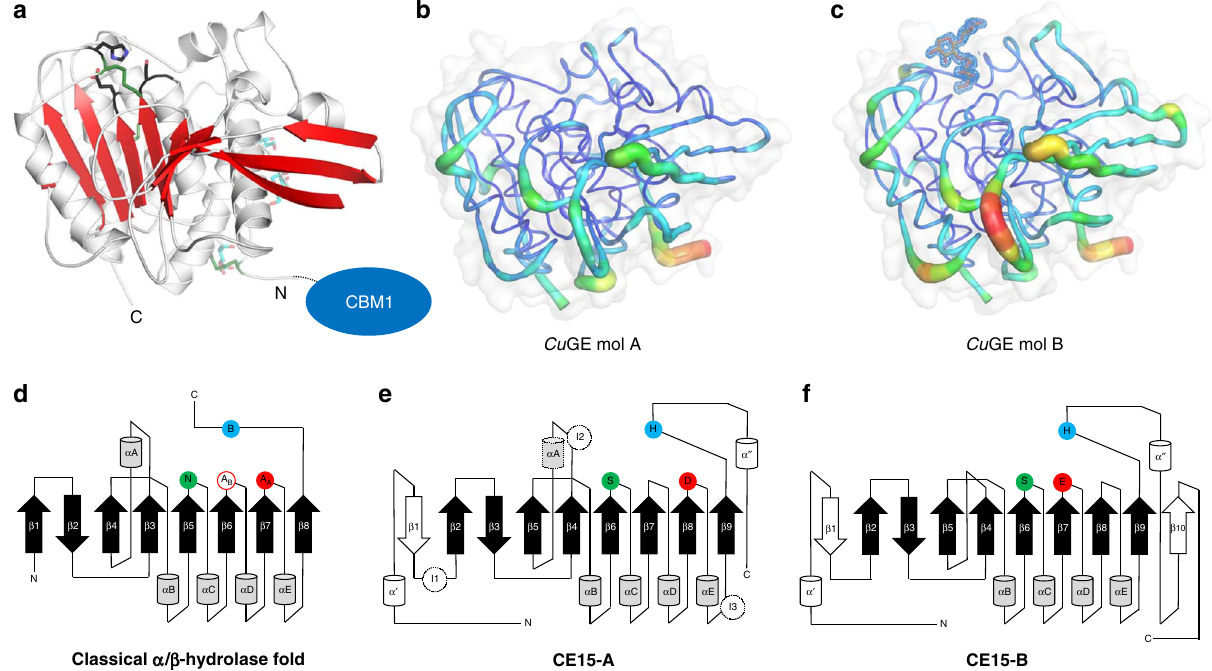
Fig. 3 Overall Cu GE structure, CE15 subgroups, and relation to the classical α / β -hydrolase fold. a Structure of the catalytic domain of Cu GE (residues 79 – 458) with selected residues shown as sticks: the catalytic triad (S270, E293, and H404, black), disul fi de bridges (C81 – C116, C269 – C405, C391 – C377, green), and carbohydrates (cyan), indicating the location of N- and O-glycosylation sites (N104-NAG, S86-MAN, and T87-MAN). The break in strand β 3 is caused by a proline residue (P169) in Cu GE. b , c The two crystallographically independent molecules A and B from the d Δ S270A:U m4 X complex colored by temperature factors to visualize fl exibility. b Molecule A. c Ligand-bound molecule B. d Topology diagram for a classical α / β -hydrolase fold. The illustration is based on information in Ollis et al. 23 , Carr et al. 24 , and Dimitrou et al. 25 . The location of the catalytic residues is shown (nucleophile serine in green, base histidine in blue, and acid glutamate in red). The α / β -hydrolase group A and B are distinguished by different con fi gurations of the catalytic triad with the catalytic acid located either in the turn after β 7 (A A ) or after β 6 (A B ), respectively 25 . e Topology diagram for CE15-A. I1-I3 indicate inserts observed in bacterial CE15-A structures 13 – 15 . f Topology diagram for CE15-B. For clarity, only the major secondary structure elements have been included in the topology diagrams in e , f ; structures from both CE15 subgroups comprise additional small secondary structure elements, including multiple helical elements inserted after the strands β 5 and β 7 (Supplementary Fig.